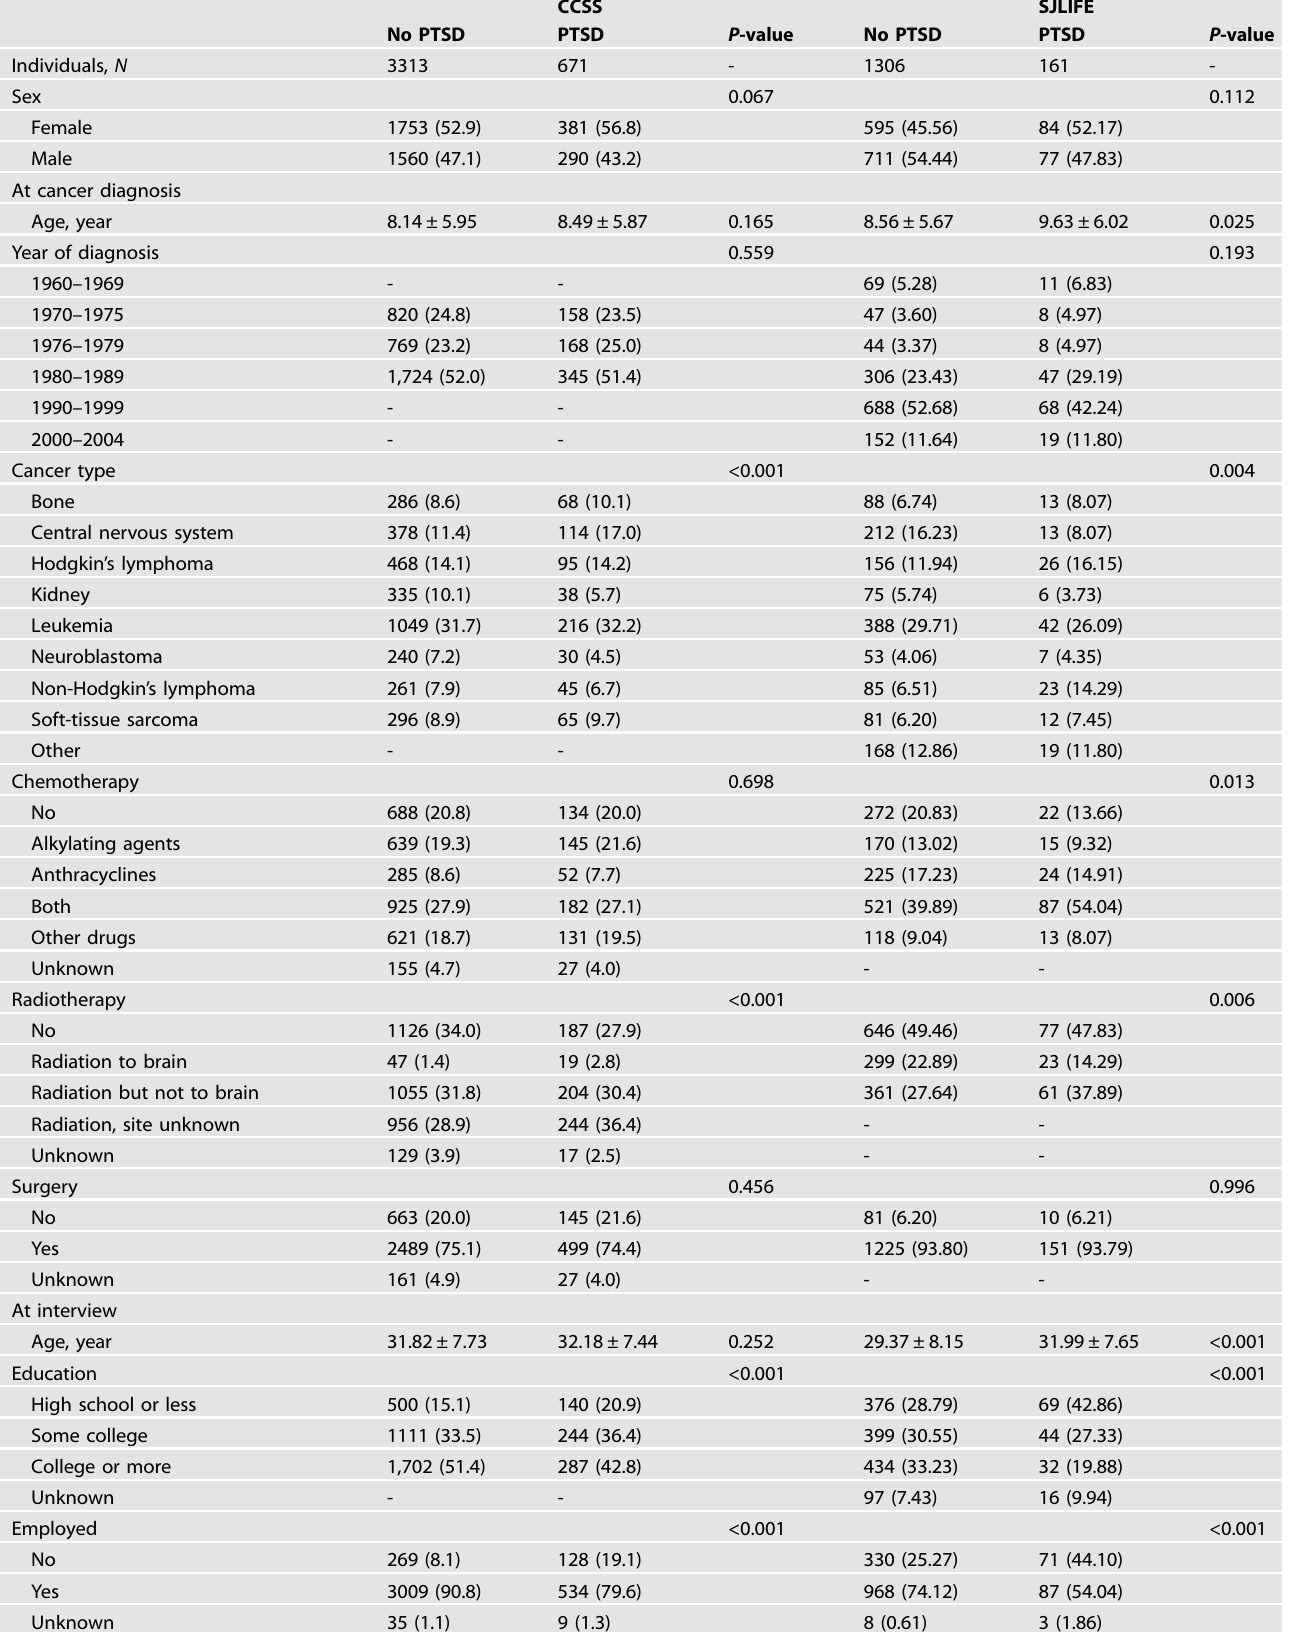
Table 1. Demographic and clinical characteristics of childhood cancer survivors in the CCSS and SJLIFE — mean ± SD or N (%). CCSS SJLIFE No PTSD PTSD P -value No PTSD PTSD P -value Individuals,